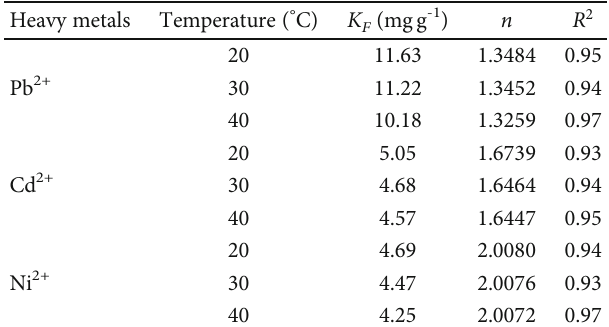
Table 3: Parameters of Freundlich adsorption